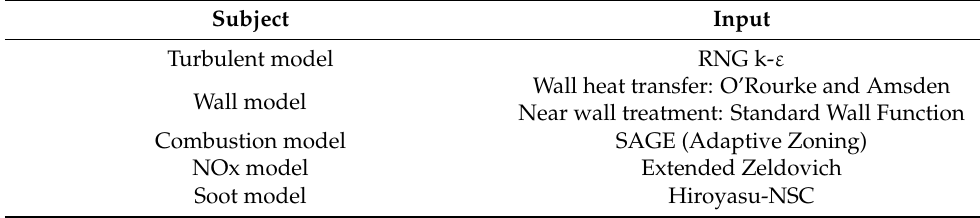
Table 4. Sub-models of the